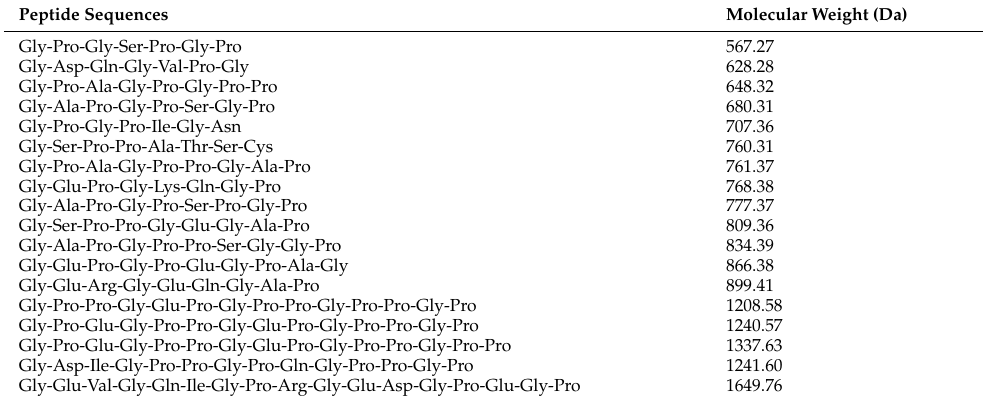
Table 1. ABPs were identified by their peptide sequences and molecular weight.